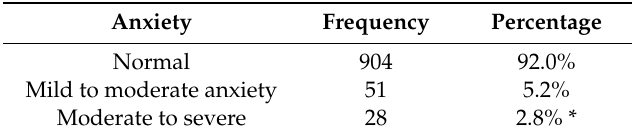
Table 2. Anxiety level based on Zung’s classification.